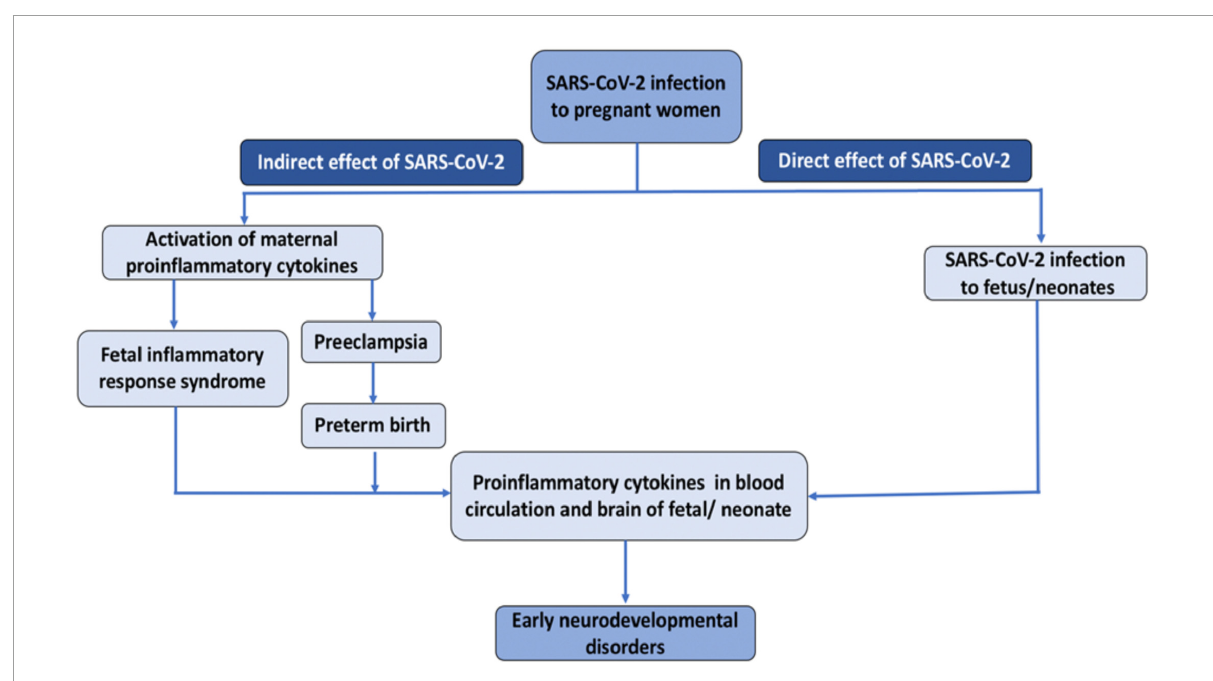
FIGURE1 Direct and indirect effect of SARS-CoV-2 infection on fetal/neonatal brain development.